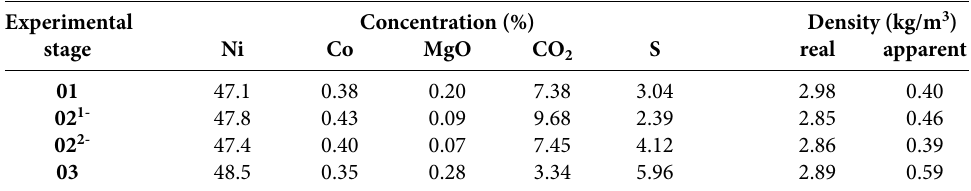
Table 1. Characterization of Basic Nickel Carbonate Experimental